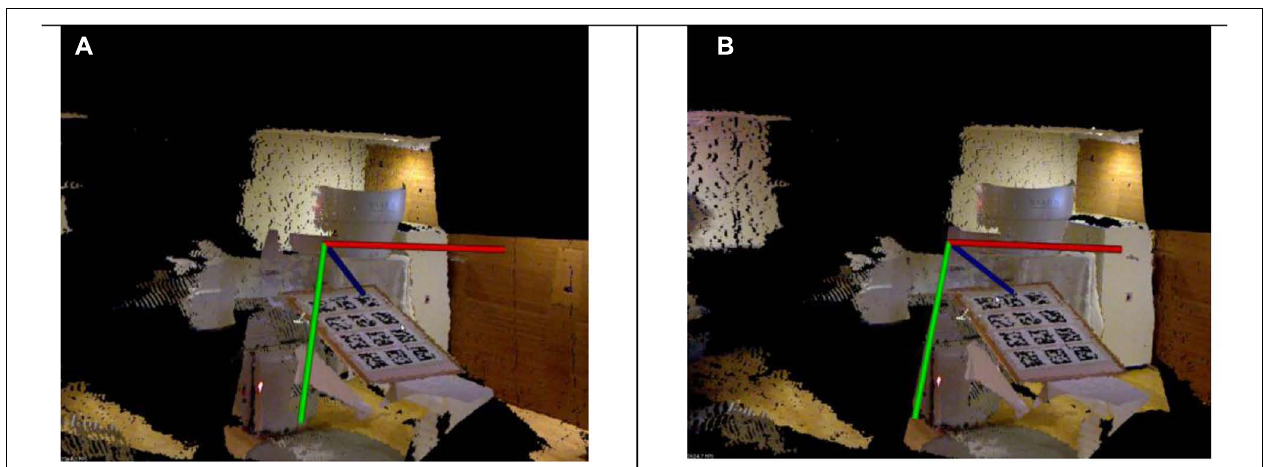
FIGURE 6 | 3D stereo images generated for each of the eyes for a known view angle. The subtle changes between the left and right eye images are shown with the coordinate system. Each of these images were encoded with H.264 standard at the server side and streamed to the client side for real-time visualization.